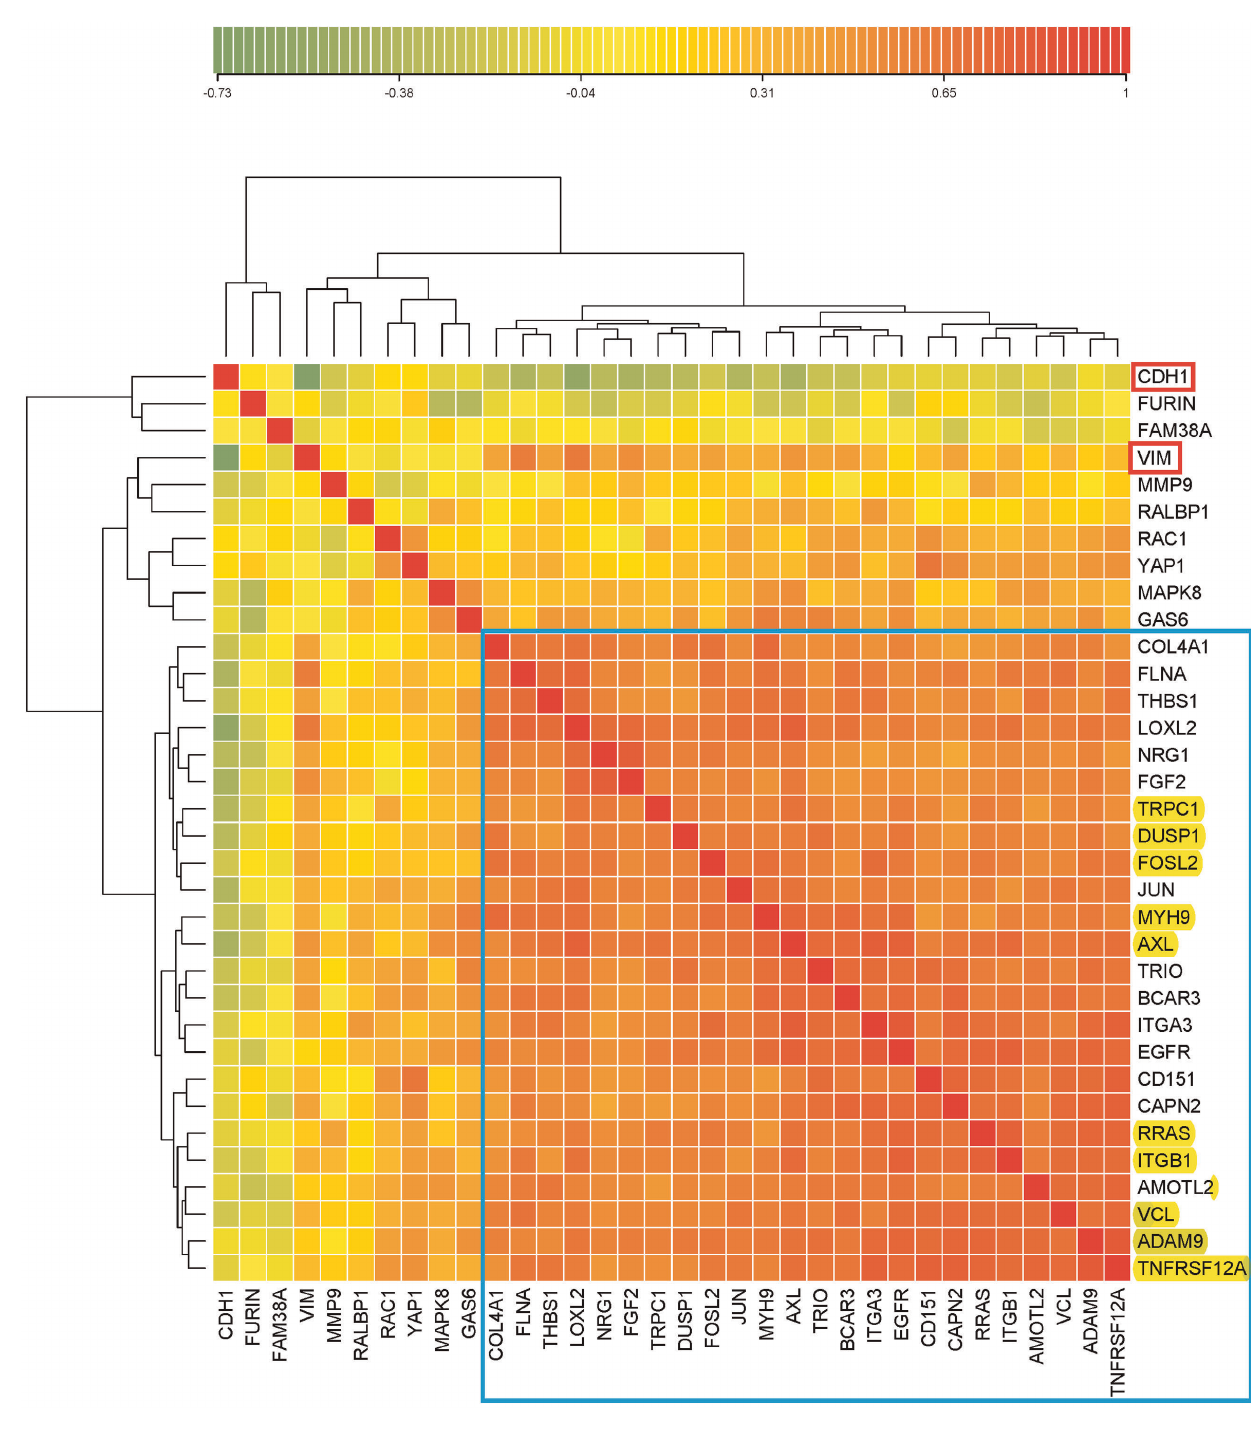
Figure 5. Correlation CIM of the same genes as in Figure 4. The genes in the blue box are the 24 high cross-correlation HCCS24 genes; these genes correlated significantly with VIM and not with CDH1, showing that they correlate with mesenchymal character. Note however that some genes correlated better than others with VIM: genes such as RAC1 and GAS6, as well as VIM, which failed to meet the strict criteria for inclusion with the HCCS24 genes, nevertheless are seen to be significantly correlated with them. Interestingly, some of the genes that were imperfectly correlated with the HCCS24 genes (i.e., GAS6, MAPK8, YAP1, and RAC1) tend to correlate inversely with VIM; the cell lines that contribute to this effect can be seen in Figure 4 (they include 4 colon lines that express CDH1 but not VIM). The low correlation of FURIN with the HCCS24 genes is attributable to its functioning in stromal rather than tumor cells (Figure 12); the low correlation of FAM38A however remains unexplained.